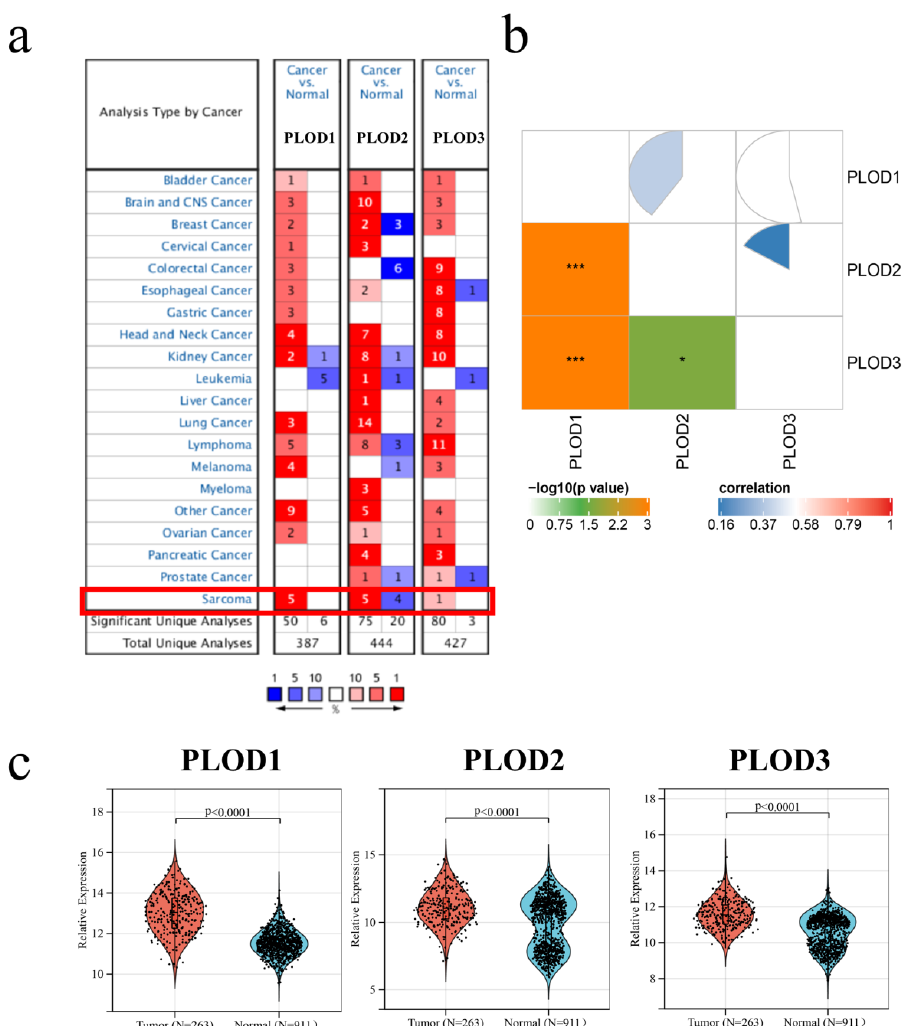
Figure 1. The expression of PLOD family members in STS using TCGA and GTEx datasets. ( a ) Expression in cancers compared to the corresponding normal tissue at transcription. The number in the cell states the amount of related analyses, which means in how many experiments the PLOD family members were high- or low- expression. The color of each cell depended upon the gene rank percentile. Red—up-/blue—downregulation. ( b ) Relation of expression levels among PLOD1–3 based on TCGA and GTEx cohort. ( c ) PLODs family members’ expressions between cancer tissues and corresponding normal tissues at transcriptional level. *: p < 0.05, ***: p < 0.001.